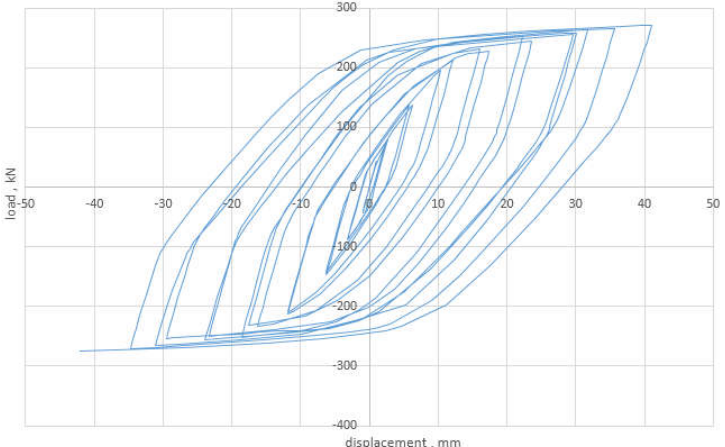
Figure 11. The hysteresis diagram due to loading on the frame.